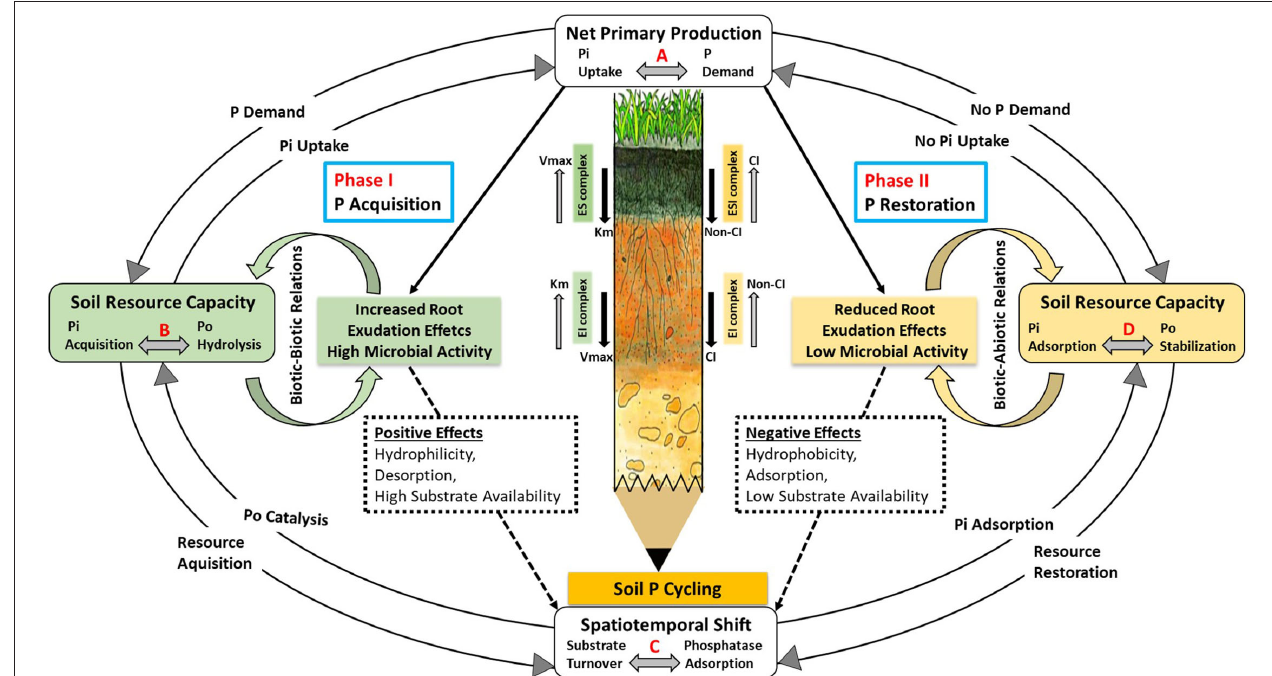
FIGURE 4 | A conceptual two-phase framework for predicting P bioavailability in ecosystems based on phosphatase activity and soil phosphatase interactions. In “Phase I”, plants acquire soil P via phosphatase activity, which is controlled by a coupled relationship (biotic relations) with soil microorganisms in the presence of exuded metabolic products such as mucilage and LMWOAs. The “phase II” is characterized by the conservation of soil P resources under the dominance of biotic and abiotic interaction among microbes, phosphatases, and the different P forms with the soil mineral surfaces in the absence of root exudation. During phase II, extracellular phosphatases are immobilized and adsorbed onto colloidal and mineral soil surfaces, which inhibits their activities through modifications in hydraulic and physicochemical properties. CI, competitive inhibition; non-CI, non–competitive inhibition; ES, enzyme–substrate; EI, enzyme–inhibitor; ESI, enzyme–substrate–